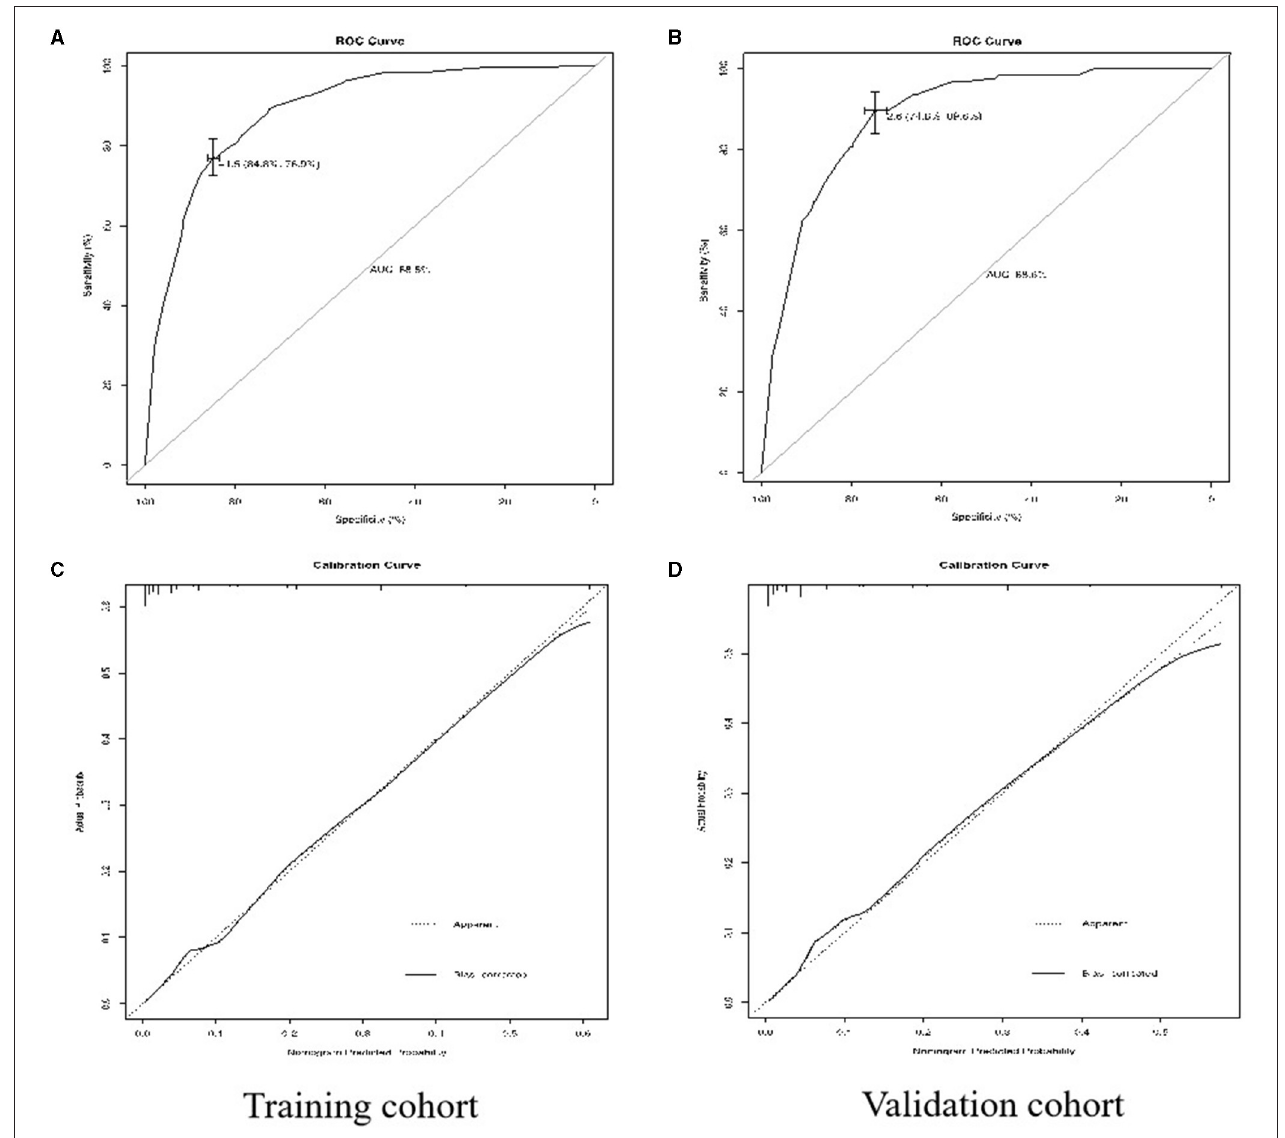
FIGURE 3 | Receiver operating characteristic (ROC) curves for predicting the parametrial involvement (PI) (A,B) and the calibration plots (C,D) in the training cohorts and the validation